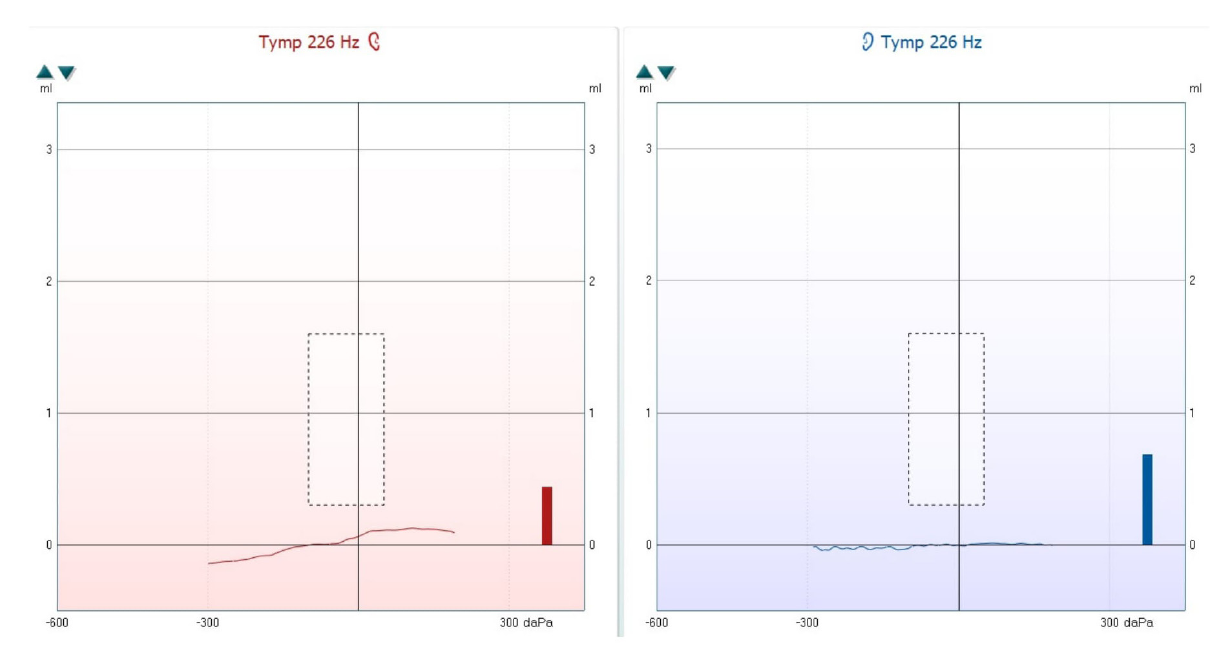
Figure 6. Results of classical tympanometry for 226 Hz, right and left